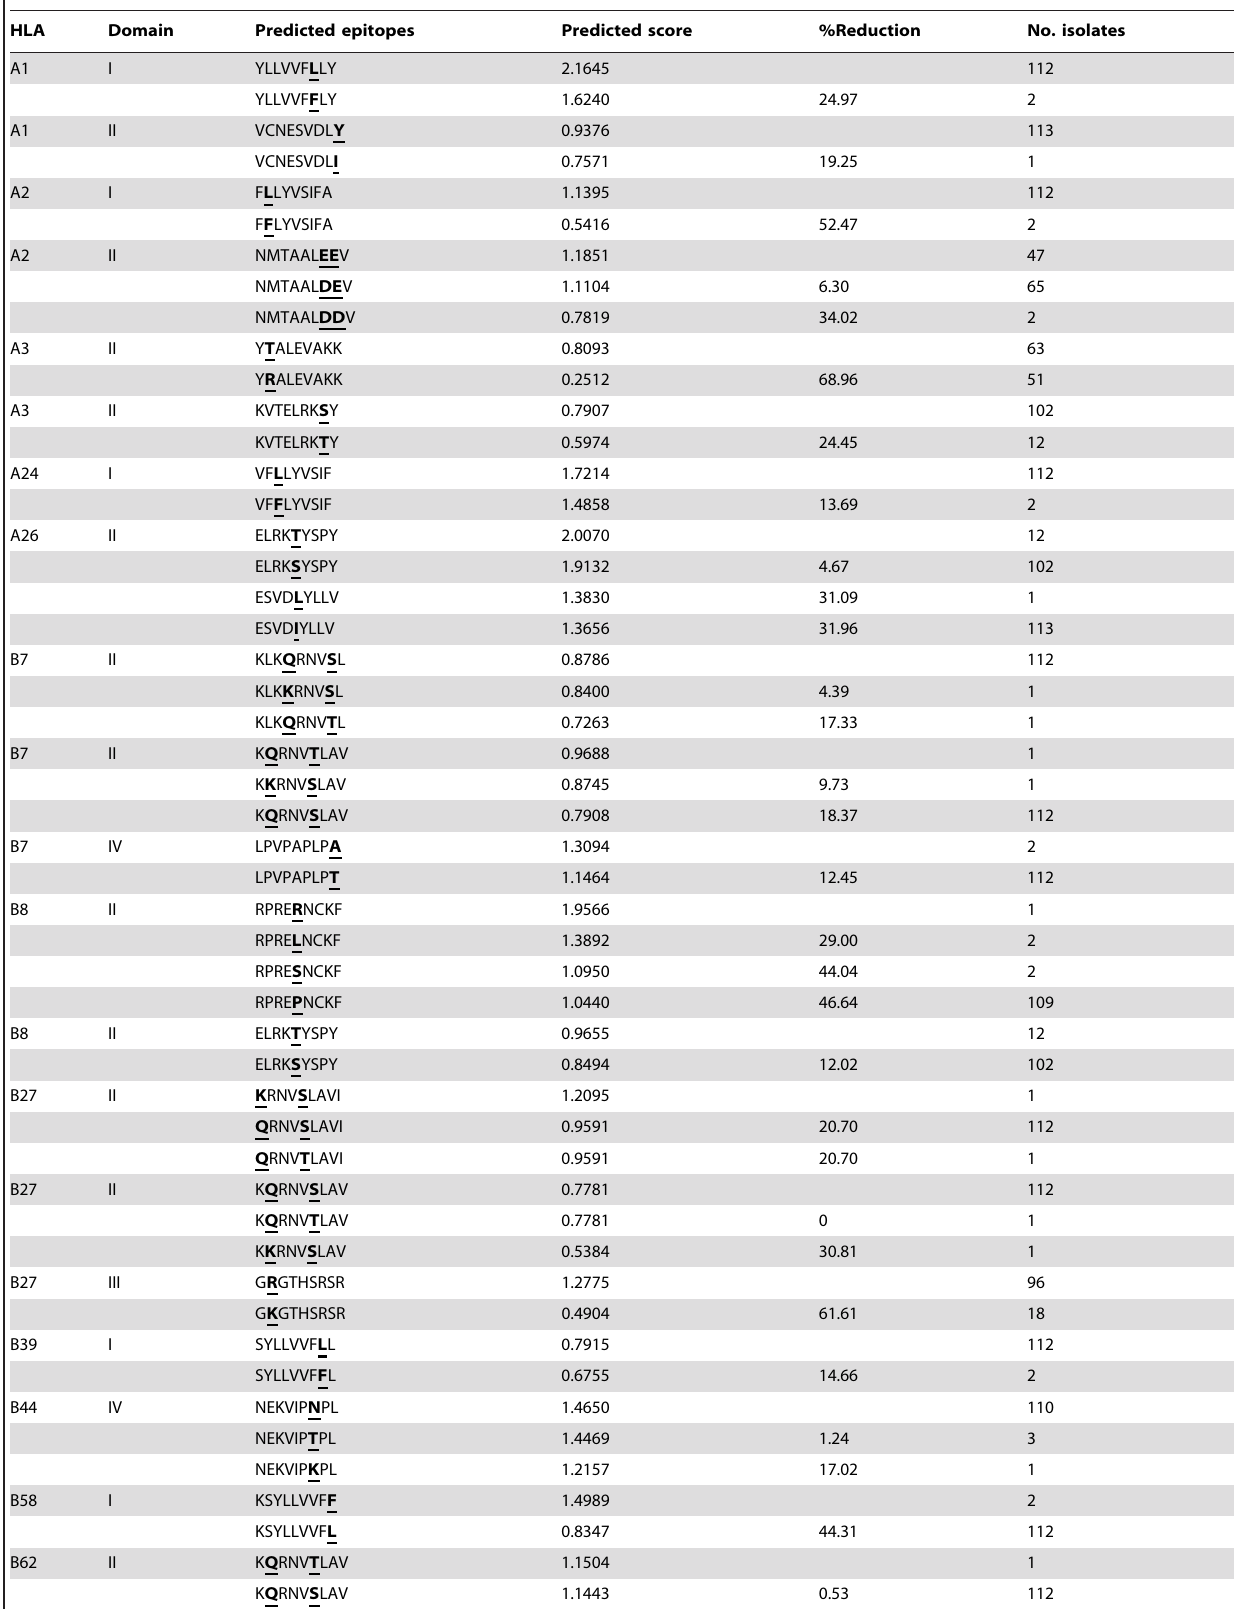
Table 7. Amino acid substitutions in potential T cell epitopes of PvTRAP and predicted scores*.